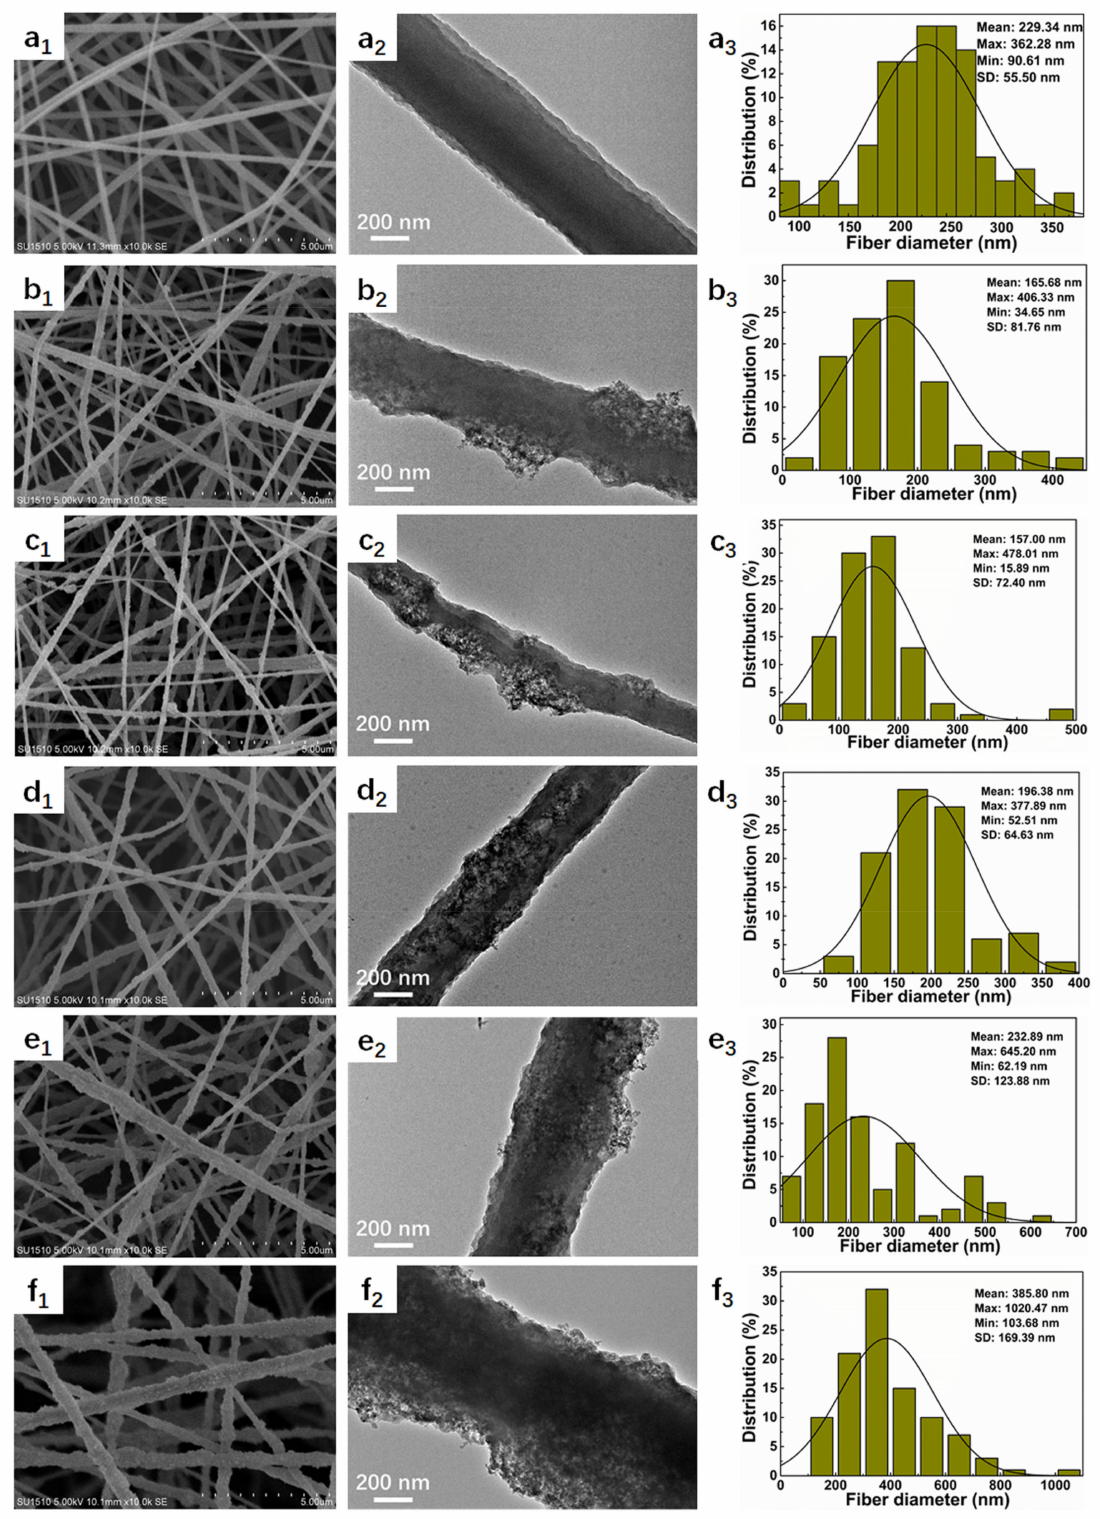
Figure 2. SEM images ( a 1 – f 1 ), TEM images ( a 2 – f 2 ), and fiber diameter distribution ( a 3 – f 3 ) of SiO 2 @ polyimide(PI)hybridmembraneswithdi ff erentSiO 2 NPcontents: ( a 1 – a 3 )0%, ( b 1 – b 3 )1.0%, ( c 1 – c 3 )1.5%, ( d 1 – d 3 ) 2.0%, ( e 1 – e 3 ) 3.0%, and ( f 1 – f 3 )